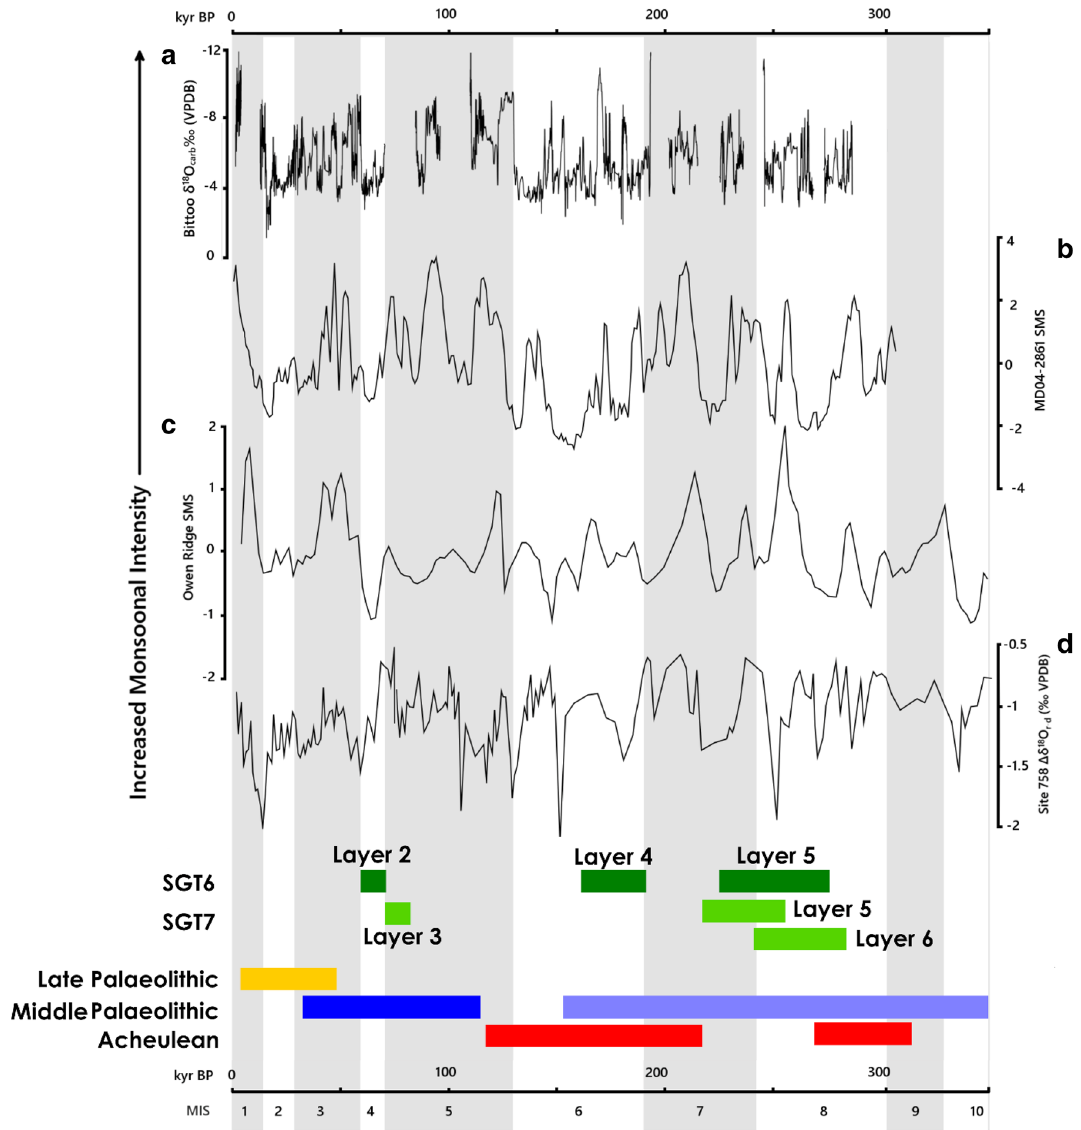
Figure 4. High altitude cave speleotherm ( a : Bittoo Cave [India] 110 ) and marine core records from the Arabian Sea ( b : MD04 111 ; c : Owen Ridge 112 ) and Bay of Bengal ( d : Site 758 113 ) illustrating patterns of monsoonal variability spanning the occupations of Singi Talav (SGT6: dark green; SGT7: light green) and major phases of cultural activity in South Asia including Late Palaeolithic (yellow) and Middle Palaeolithic (dark blue) 26 , Attirampakam Middle Palaeolithic (light blue [NB only two assemblages present]) 39 , and Late Acheulean (red) 2,58,62 . Phases of lacustrine deposition at Singi Talav are associated with both prominent peaks and troughs of monsoonal intensity during glacial phases (MIS 8, 6 and 4) evident in Arabian Sea records, highlighting the importance of terrestrial proxy records to understand how wider patterns of climatic flux may have been manifest in landscapes occupied by Palaeolithic